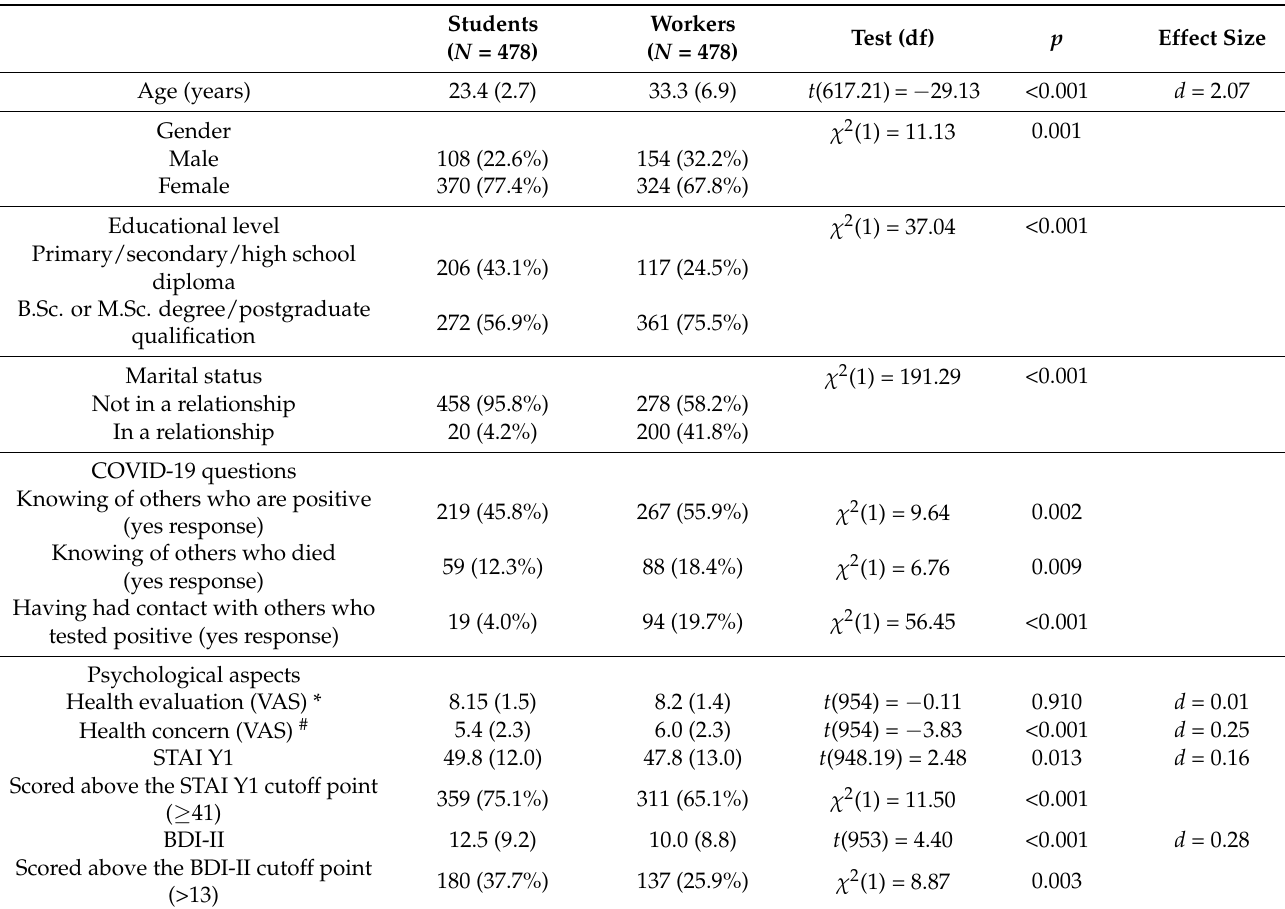
Table 1. Sociodemographic characteristics of student and worker groups. Mean (SD), percentage, t -test, and Cohen’s d are